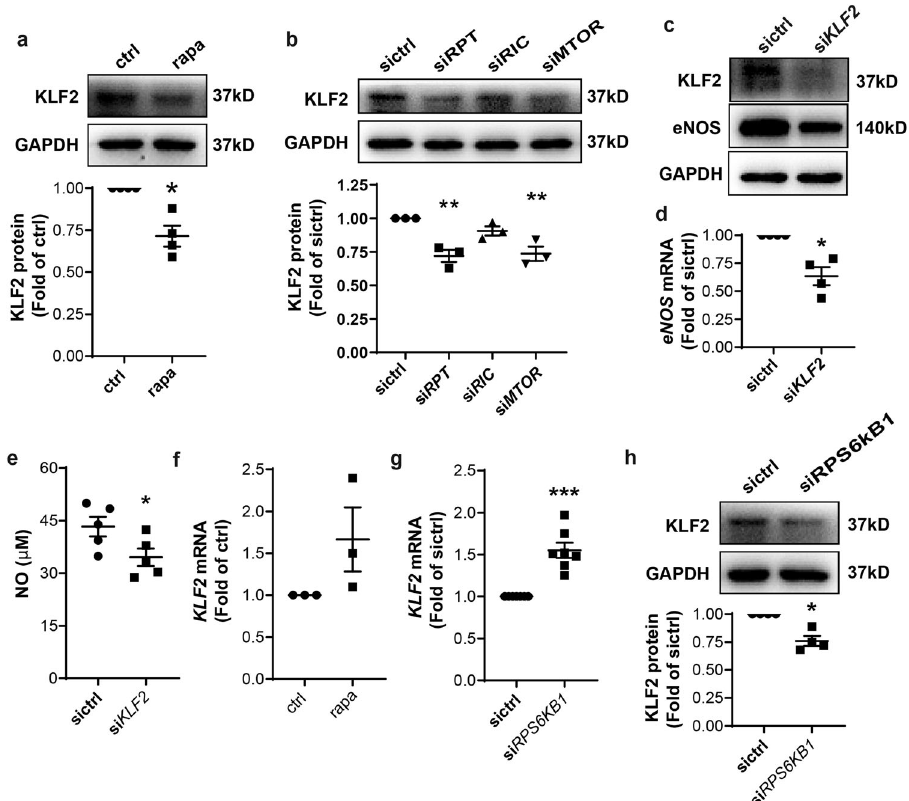
Fig. 4 p70S6K downstream of mTORC1 contributed to eNOS transcription through translational regulation of KLF2 expression. a , b HAEC were treated with 1 nM rapa or transfected with siRNA prior to Western blot analysis and quanti fi cation of KLF2 expression ( n = 3 – 4). c , d HAEC were transfected with KLF2 -targeting siRNA followed by Western blotting (c) and quantitative PCR ( n = 4, d ). e At 48 h post-transfection with siRNA against KLF2 , relative NO level of the culture medium was measured with the colorimetric assay ( n = 5). f HAEC were treated with 1 nM rapa for 1 h, prior to quantitative PCR to measure mRNA ( n = 3). g , h HAEC were transfected with siRNA against RPS6KB1 followed by quantitative PCR ( n = 7, g) or western blotting ( n = 4, h ) to quantify KLF2 expression. ** p < 0.01; *** p < 0.001 vs. sictrl or ctrl; one-sample t test ( a , d , f , g , h ) or RM one-way ANOVA with Dunnett ’ s test ( b ) or unpaired two-tailed t test ( e (Supplementary Fig. 3d), excluding the involvement of iNOS in this process. Together these results con fi rmed the existence of eNOS uncoupling in mTORC2-inhibited cells.